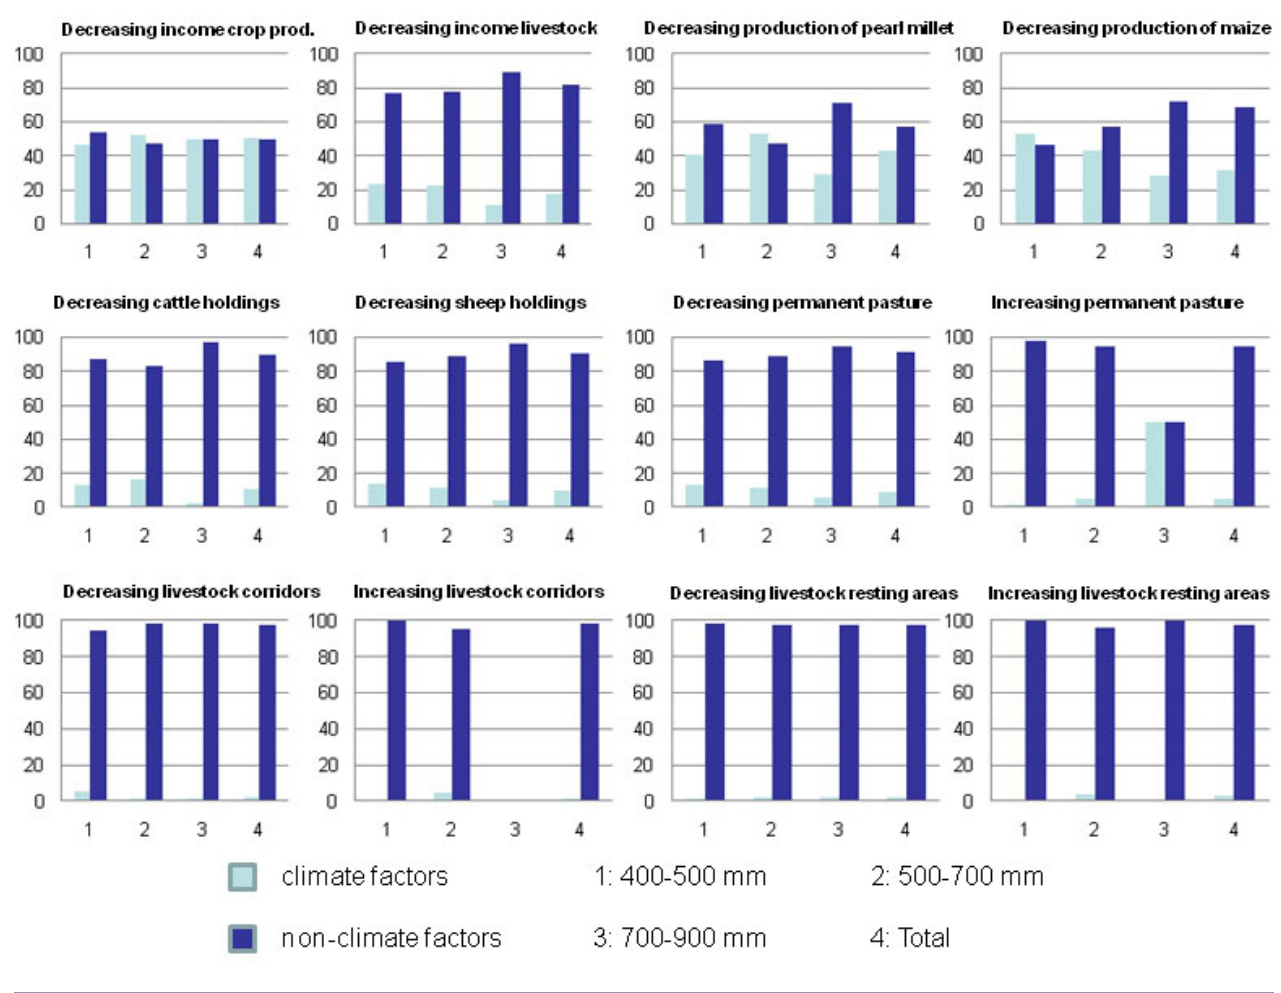
Fig. 4. The causes of change due to aggregated climate factors (rainfall, wind, temperature, drought, flooding, etc.) and aggregated nonclimate factors: decreasing income from crops (N=1044, p=0.37, nonsignificant) and livestock (N=311, p < 0.05), decreasing crop production (pearl millet, N=2501, p < 0.05; maize, N=917, p < 0.05) and livestock production (cattle, N=515, p < 0.05; sheep, N=571, p < 0.05), and change in pasture areas: permanent pasture (increasing N=134, p < 0.05; decreasing N=560, p < 0,05), livestock corridors (increasing N=108, p < 0,05; decreasing N=438, p=0.21, nonsignificant), and livestock resting areas (increasing N=111, p < 0.05; decreasing N=392, p=0.93, nonsignificant). Significance levels refer to differences in perceptions between rainfall